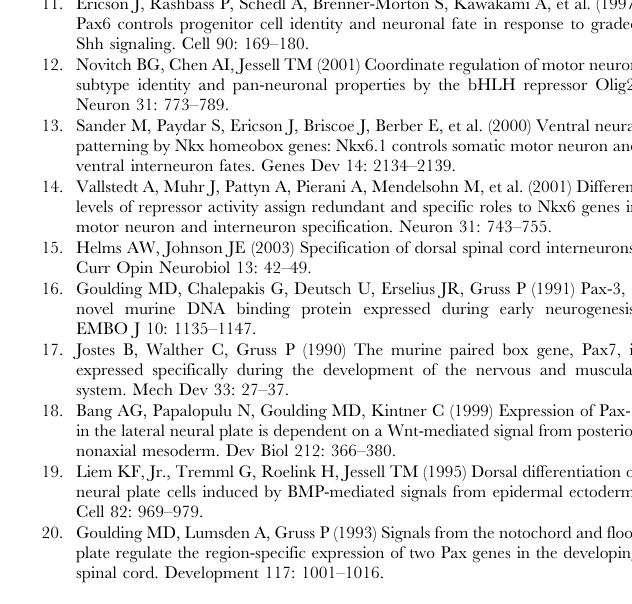
Table S1 Annotation of conserved TFBS within CNE3. Table S2 Annotation of conserved TFBS within CNE1. Table S3 List of oligonucleotides used in the